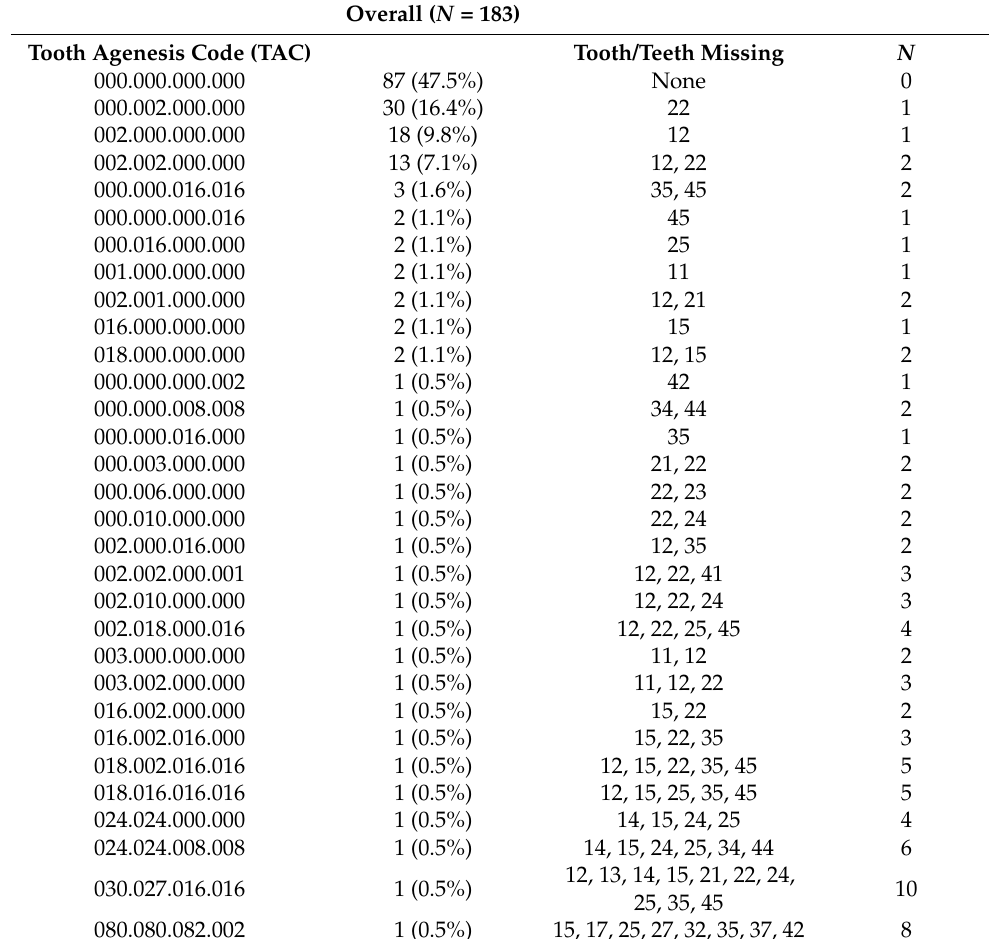
Table 2. Distribution of tooth agenesis code (TAC), corresponding missing teeth and number of missing teeth ( N ) in the whole sample.